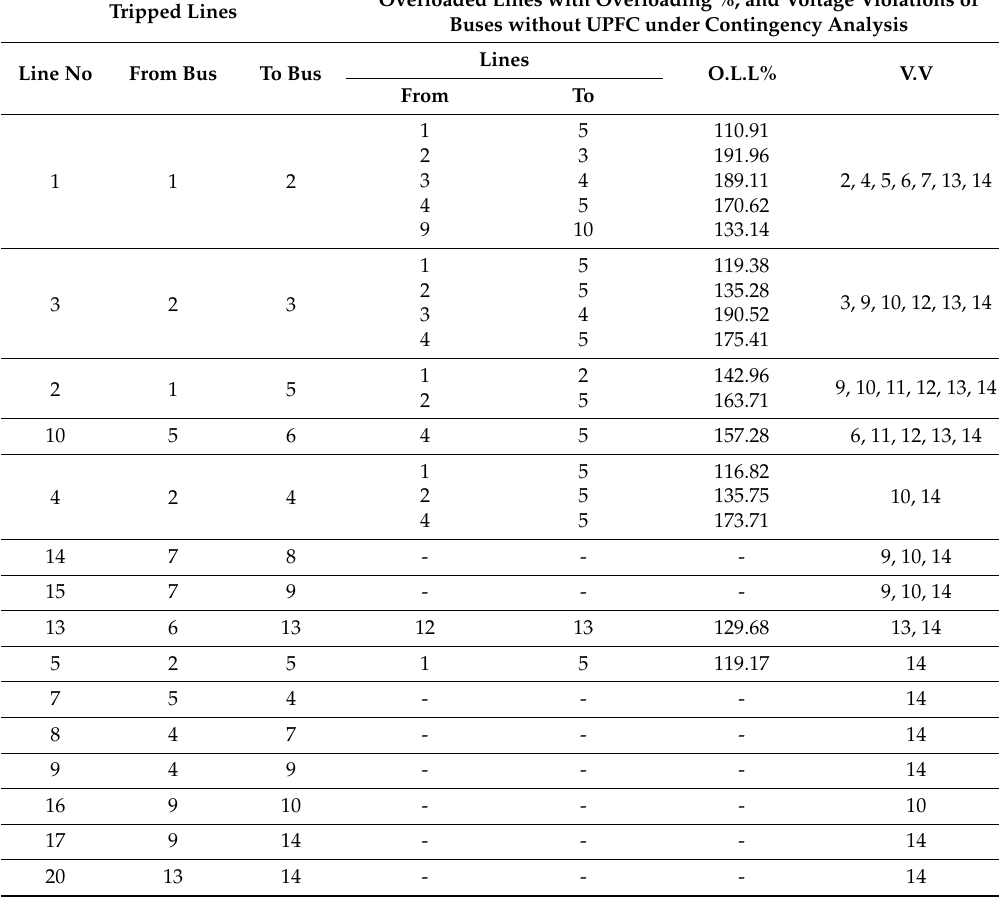
Table 4. Overloading lines with percentage and bus voltage violations without